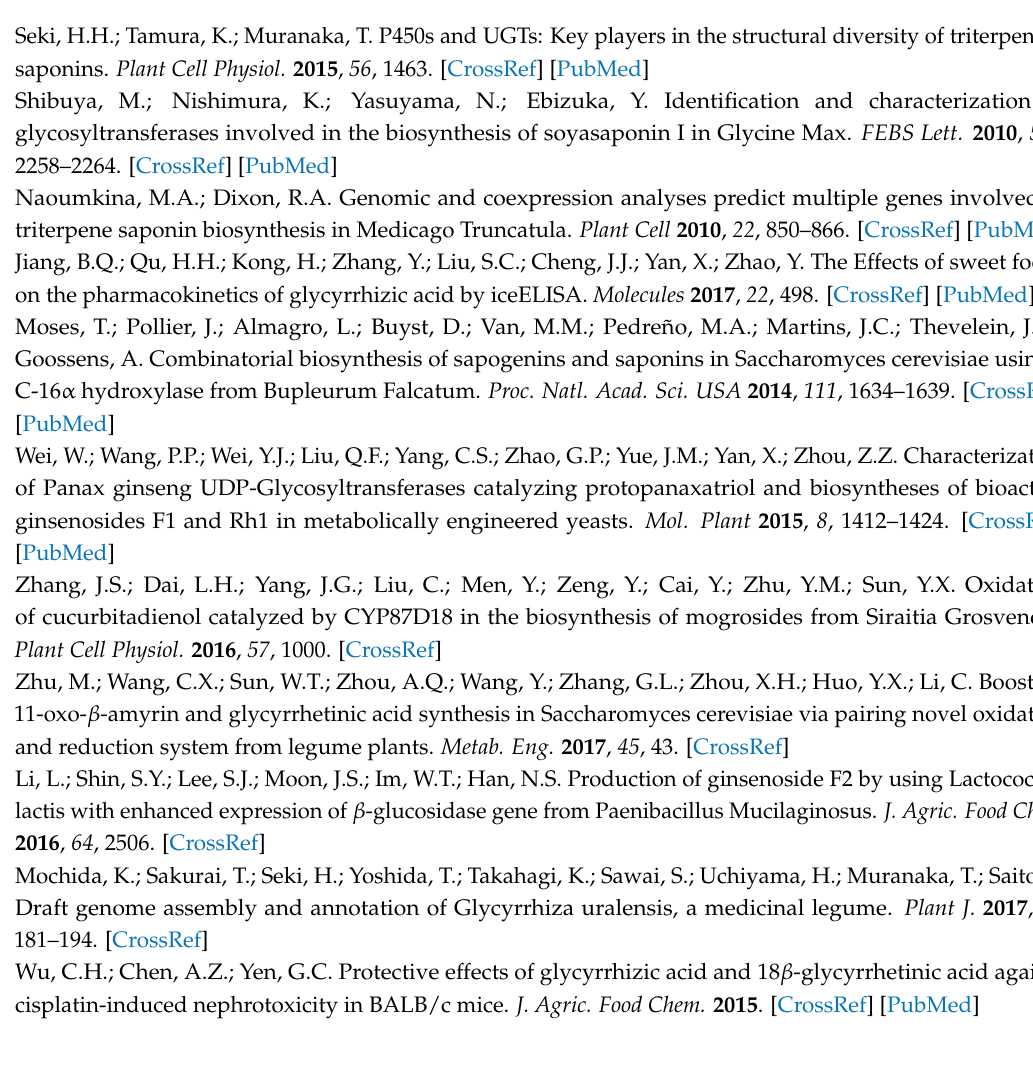
NMR spectrum of product 2 (Methanol- d 4 ). Figure S10. HMBC spectrum of product 2 (Methanol- d 4 ). Figure S11. HSQC NMR spectrum of product 2 (Methanol- d 4 ). Figure S12. COSY spectrum of product 2 (Methanol- d 4 ). Figure S13. 1 H NMR spectrum of product 3 (Methanol- d 4 ). Figure S14. 13 C NMR spectrum of product 3 (Methanol- d 4 ). Figure S15. HMBC spectrum of product 3 (Methanol- d 4 ). Figure S16. HSQC spectrum of product 3 (Methanol- d 4 ). Figure S17. COSY spectrum of product 3 (Methanol- d 4 ). Figure S18. 1 H NMR spectrum of product 4 (Methanol- d 4 ). Figure S19. 13 C NMR spectrum of product 4 (Methanol- d 4 ). Figure S20. HMBC spectrum of product 4 (Methanol- d 4 ). Figure S21. HSQC spectrum of product 4 (Methanol- d 4 ). Figure S22. COSY spectrum of product 4 (Methanol- d 4 ). Figure S23. 1 H NMR spectrum of product 5 (Methanol- d 4 ). Figure S24. 13 C NMR spectrum of product 5 (Methanol- d 4 ). Figure S25. HMBC spectrum of product 5 (Methanol- d 4 ). Figure S26. HSQC spectrum of product 5 (Methanol- d 4 ). Figure S27. COSY spectrum of product 5 (Methanol- d 4 ). Figure S28. 1 H NMR spectrum of product 6 (Methanol- d 4 ). Figure S29. 13 C NMR spectrum of product 6 (Methanol- d 4 ). Figure S30. HMBC spectrum of product 6 (Methanol- d 4 ). Figure S31. HSQC NMR spectrum of product 6 (Methanol- d 4 ). Figure S32. COSY spectrum of product 6 (Methanol- d 4 ). Figure S33. Kinetic Parameters of Bs-YjiC toward GA